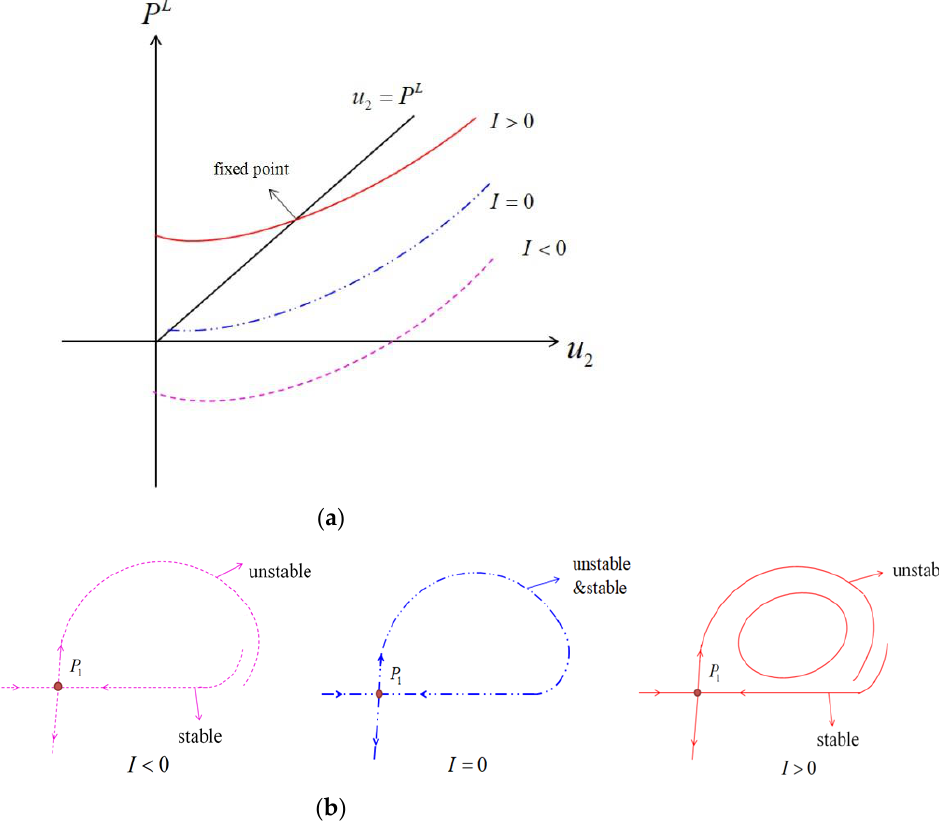
c > 1, ( a ) The fixed point diagram. ( b ) The position c 2 1  , ( a ) The fixed point diagram. ( b ) The position c 2